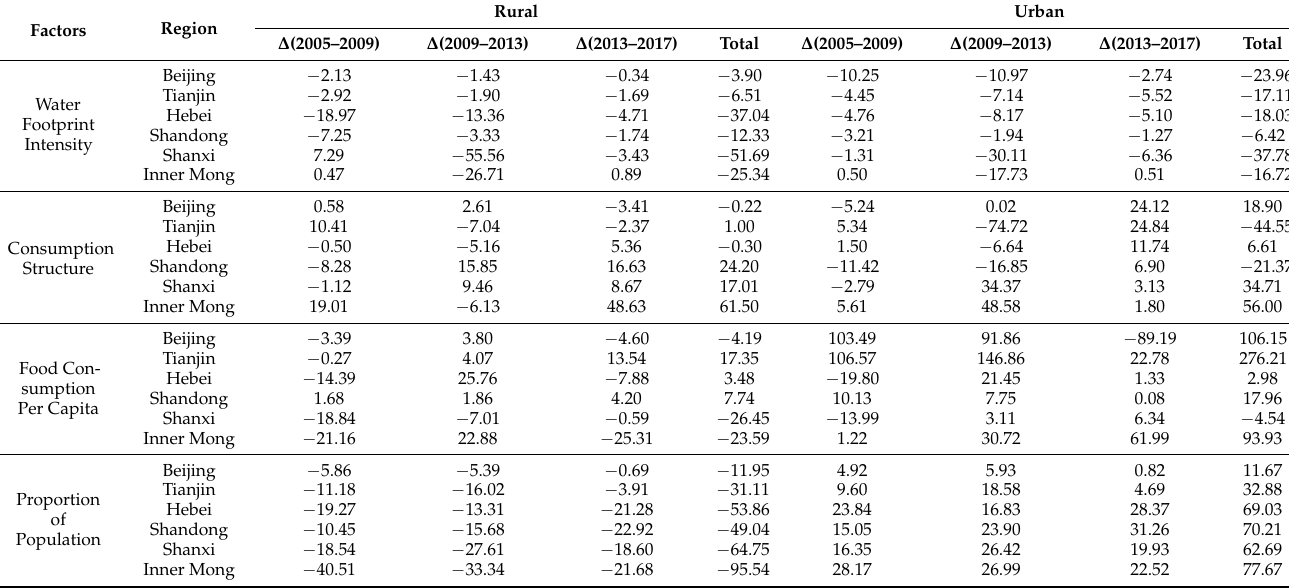
Table A2. The contribution value of each factor to the six provinces in North China’s WF changes (m 3 ).